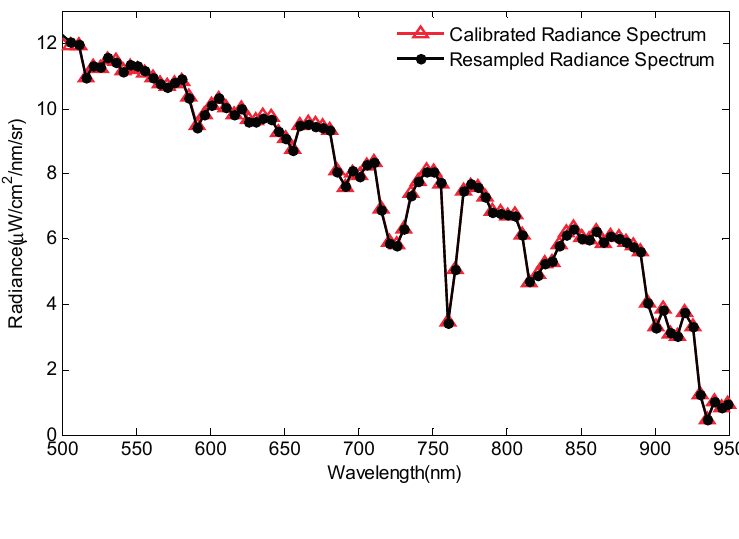
Figure 12. The comparison of the calibrated radiance spectrum and the spectrally resampled